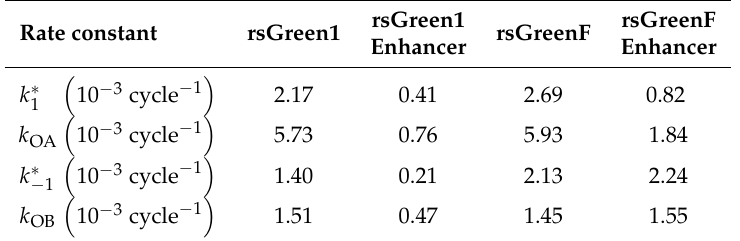
Table A3. Aggregate rate constants for the two species in the proposed